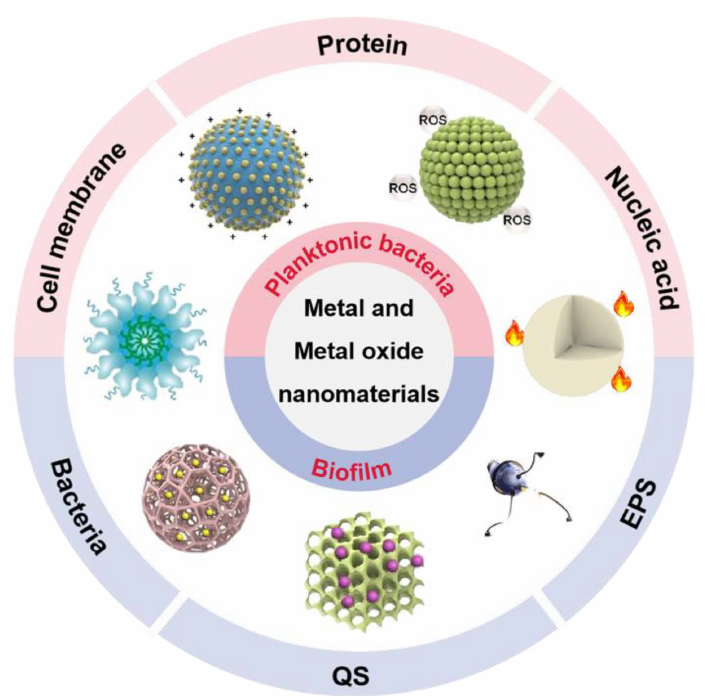
Figure 1. The antibacterial and antibiofilm application of metal and metal oxide nanomaterials. EPS: extracellular polymeric substance; QS: quorum sensing; ROS: reactive oxygen